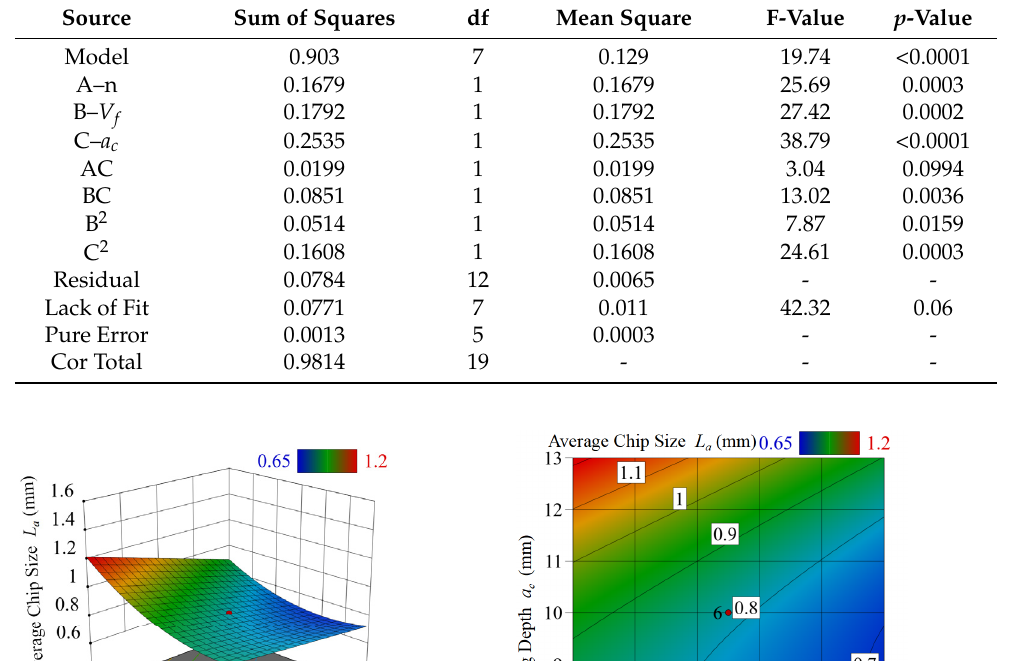
0.9201, 0.8735, and 0.6484, respectively, with an adeq precision value of 16.9314. The overall regres ‐ sion of the model is considered to be highly significant, with a p ‐ value less than 0.0001. The f ‐ value of 19.74 indicates that the probability of the model being influenced solely by noise is only 0.01. All variables included in the table are significant, with p < 0.05 indicating high significance, 0.1 < p < 0.05 indicating significance, and p > 0.1 signifying insignificance.